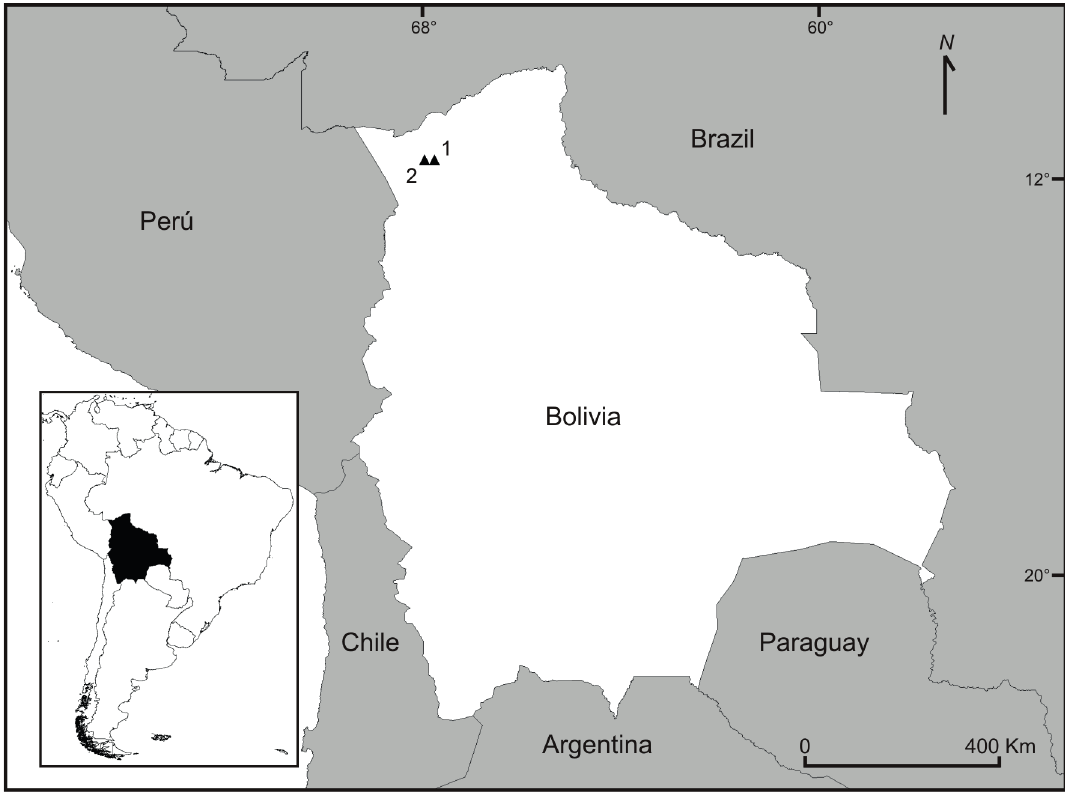
Figure 1 - Map of the study area and boreholes location: 1- Pando X-1 (11º 36’ 07’’ S, 67º 56’ 45’’ W) and 2-